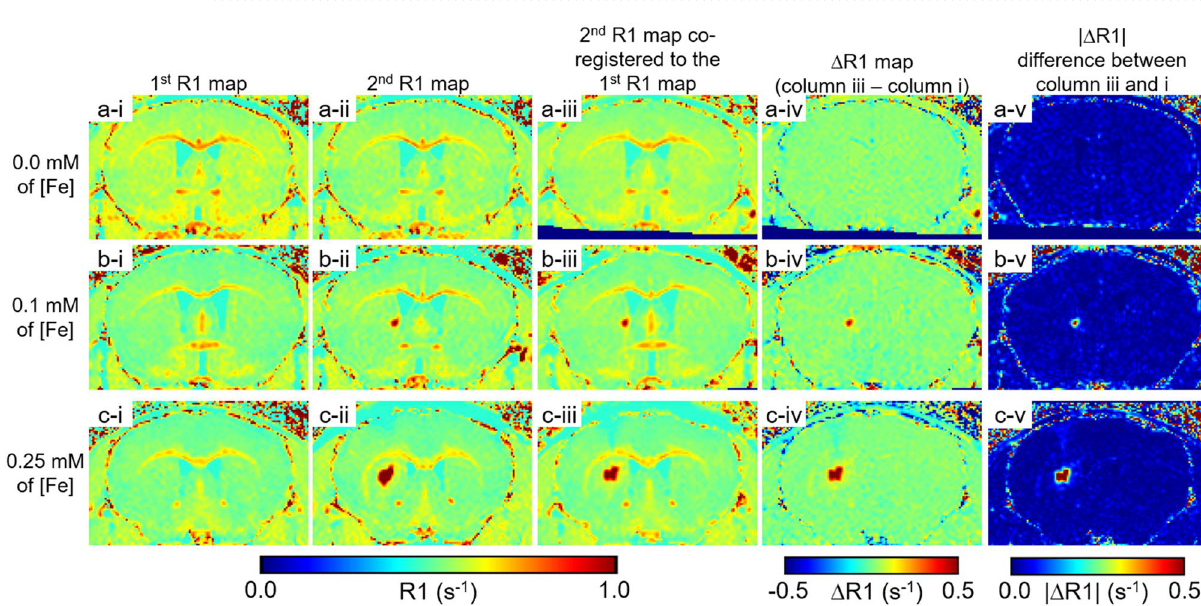
Figure 6. Detection of Extremely Small Iron Oxide Nanoparticles (ESIONPs) stereotaxically Injected into the Mouse Brain in vivo by MP2RAGE MRI. All maps were zero-filled from 160 × 160 × 160 µm 3 to 80 × 80 × 80 µm 3 . ( a-i,b-i,c-i ) R1 maps from pre-injection MP2RAGE scans of 3 individual mice. ( a-ii ) R1 map from MP2RAGE scan after injection of saline. ( b-ii ) R1 map from MP2RAGE scan after injection of 1 µl of ESIONPs at 0.1 mM iron concentration (0.1 nMol iron). ( c-ii ) R1 map from MP2RAGE scan after injection of 1 µl of ESIONPs at 0.25 mM iron concentration (0.25 nMol iron). ( a-iii,b-iii,c-iii ) R1 maps after injection co-registered to pre-injection. ( a-iv,b-iv,c-iv ) ΔR1 maps of pre-injection scan from post-injection scans co-registered to the pre- injection. ( a-v,b-v,c-v ) Absolute ΔR1 maps between pre-injection scan and post-injection scans co-registered to the pre-injection. The R1 enhancing effect of injected ESIONP is evident in both ΔR1 and absolute ΔR1 (|ΔR1|)